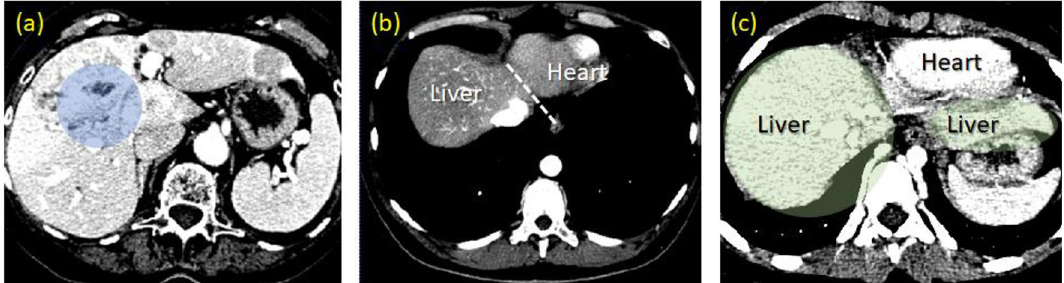
Figure 1. Challenges associated with liver segmentation, i.e., inhomogeneity of intensity in the liver region ( a ), fuzzy separation between liver and heart ( b ) and the multi-segments geometry within single slide ( c ). In addition, these cases exhibit different intensity ranges of liver